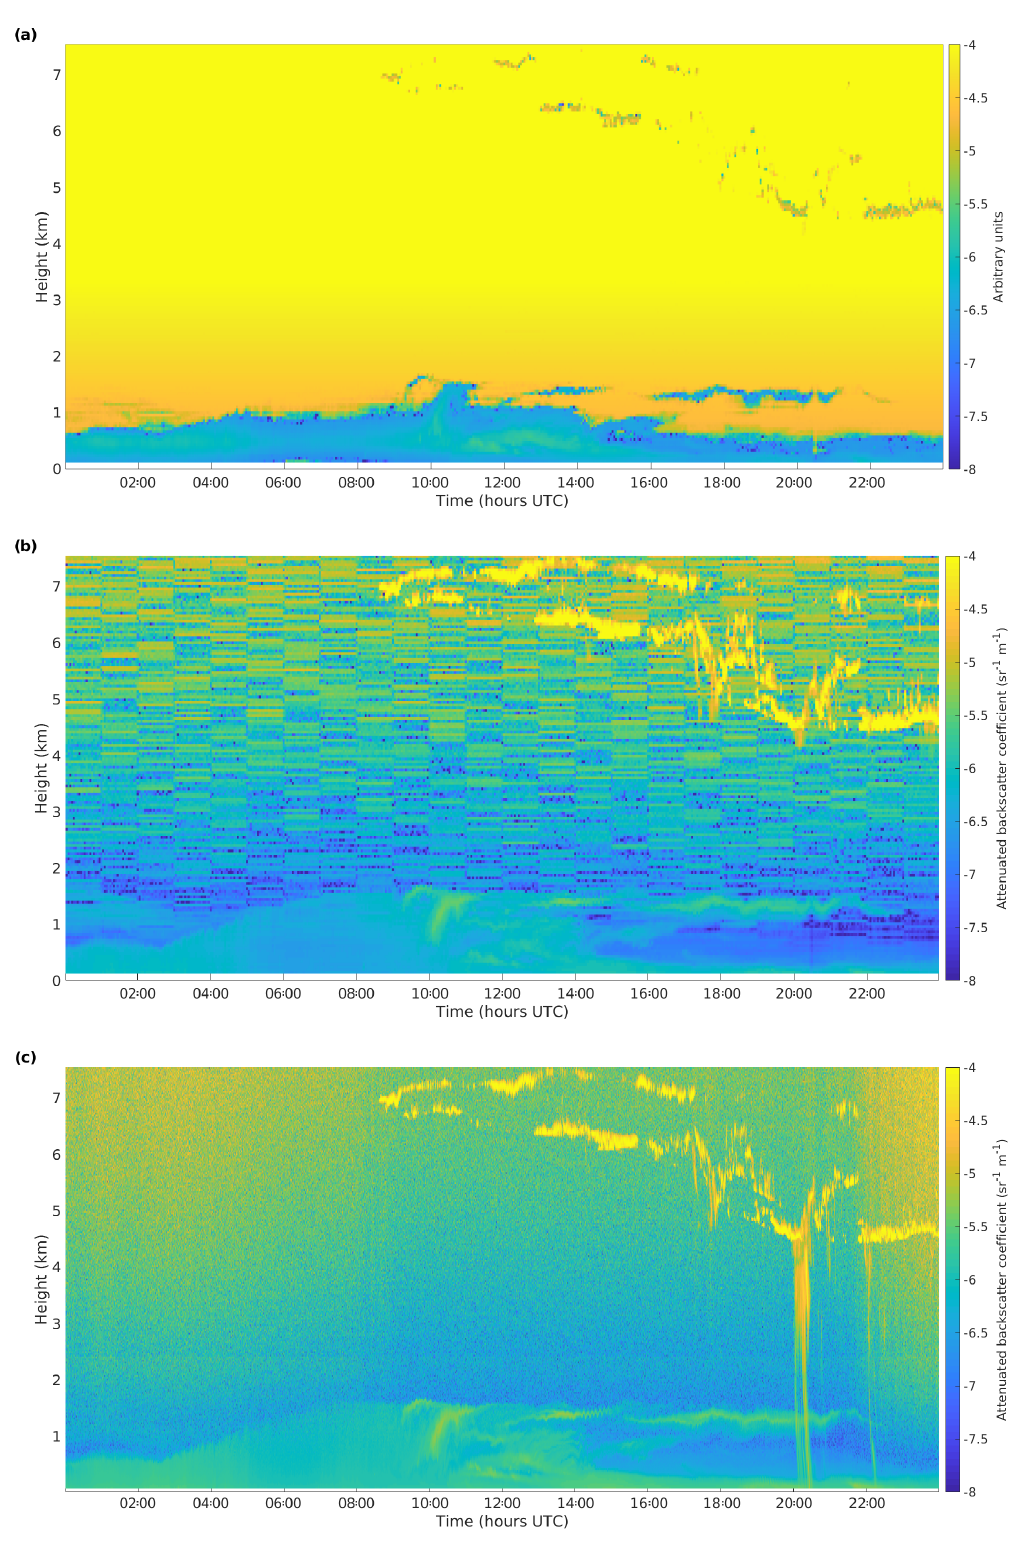
Figure 4. (a) Doppler lidar attenuated backscatter coefficient assuming a generic T f (R) , (b) corrected Doppler lidar attenuated backscatter coefficient, and (c) ceilometer attenuated backscatter coefficient, from Darwin on 28 May